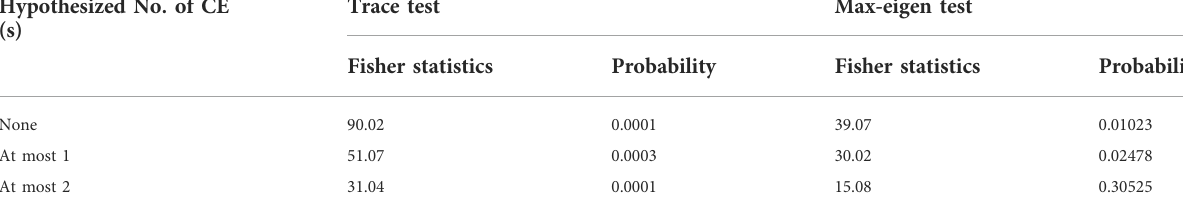
A real equilibrium return for nation ‘ i ’ at a time ‘ t ’ is denoted by the run “ ERER. ” Eq. 5 shows that the run of trade, relative productivity differences (RPDs), investment openness (TOE), and net foreign assets (NA) in fl uence Turkey ’ s equilibrium REER and that currency misalignment is at a signi fi cant level once RER misalignment is assessed.